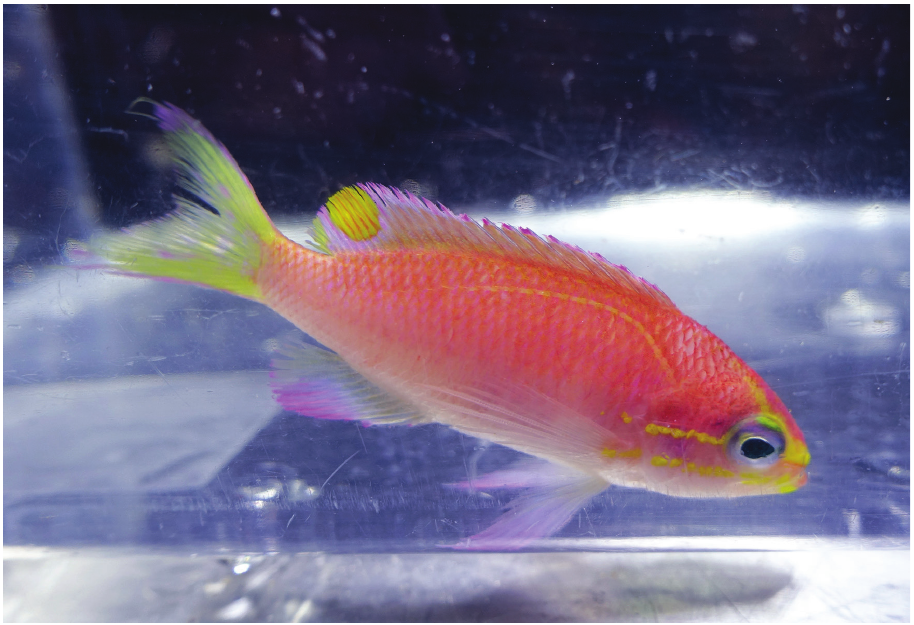
Figure 5. Holotype of Tosanoides obama shortly after collection, alive in a holding tank aboard the NOAA Ship Hi’ialakai . Photo by R. L. Pyle.